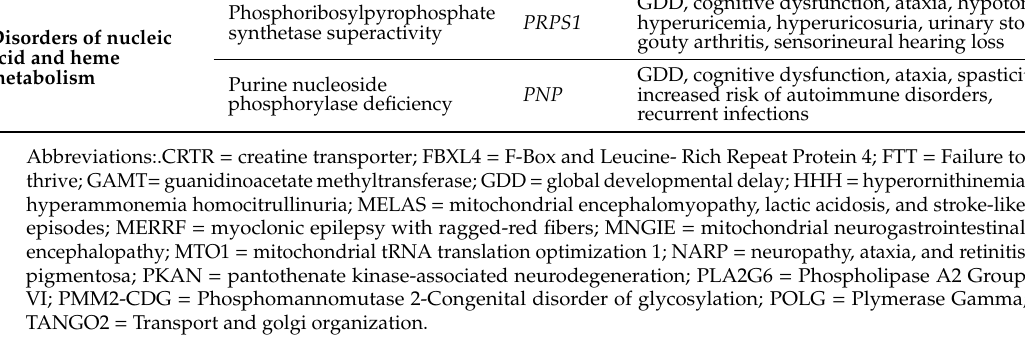
Table 2. Metabolic investigations for inherited metabolic disorders causing